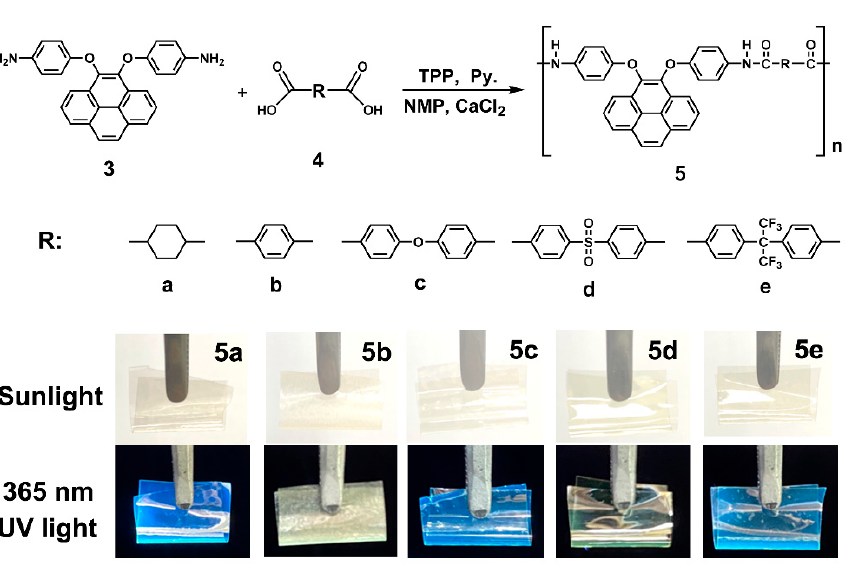
Figure 4. ( a ) Conclusive structure of diamine 3 using single-crystal X-ray analysis and the ( b ) front view and ( c ) side view of single-crystal lattice with cross-section profiles.